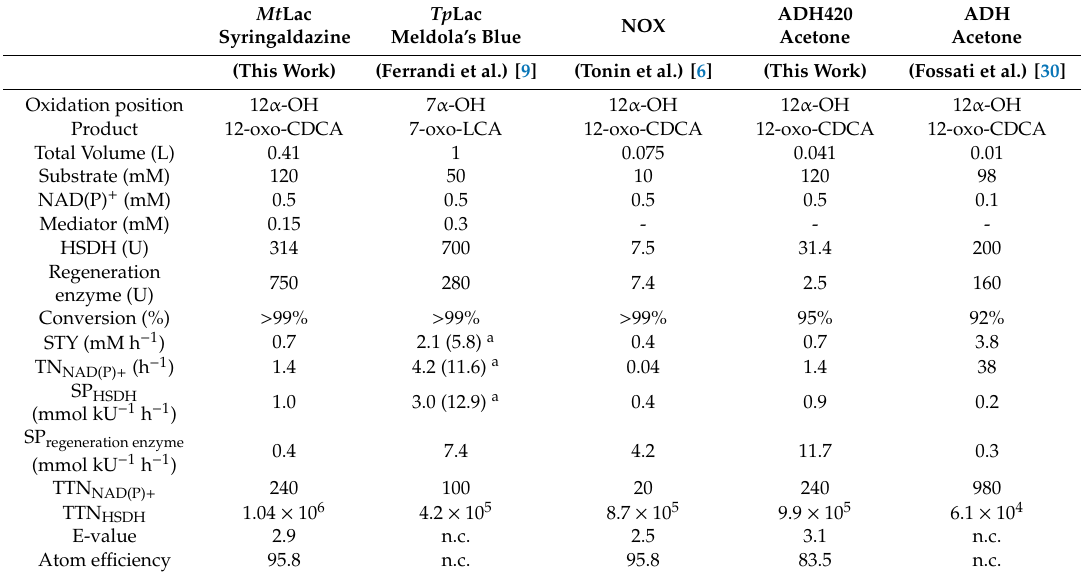
regeneration systems employed in this